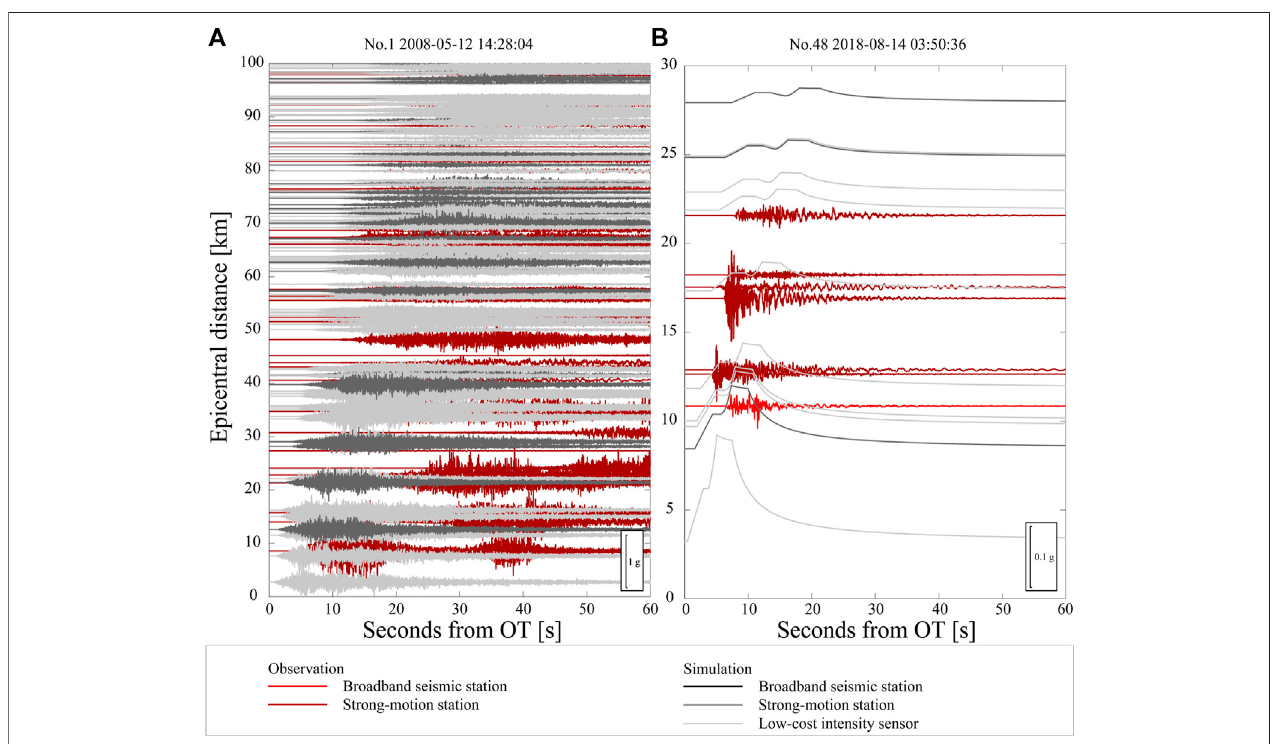
FIGURE 5 | Observed and simulated waveforms (vertical component) for the (A) 2008 Wenchuan M W 7.9 earthquake and (B) a smaller M W 4.9 earthquake, correspondingtoeventsno.1and48in Table1 .TheWenchuanearthquakeismodelledfrommultiplestackedenvelopesandastochastictime series;thesmaller event from a single waveform envelope. See main text for further